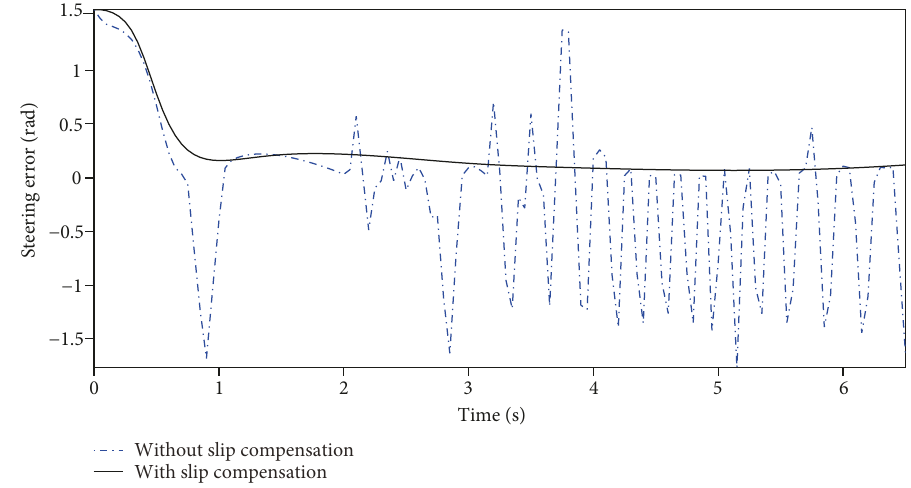
Figure 7: The comparison of error in the steering angle with active slip compensation.